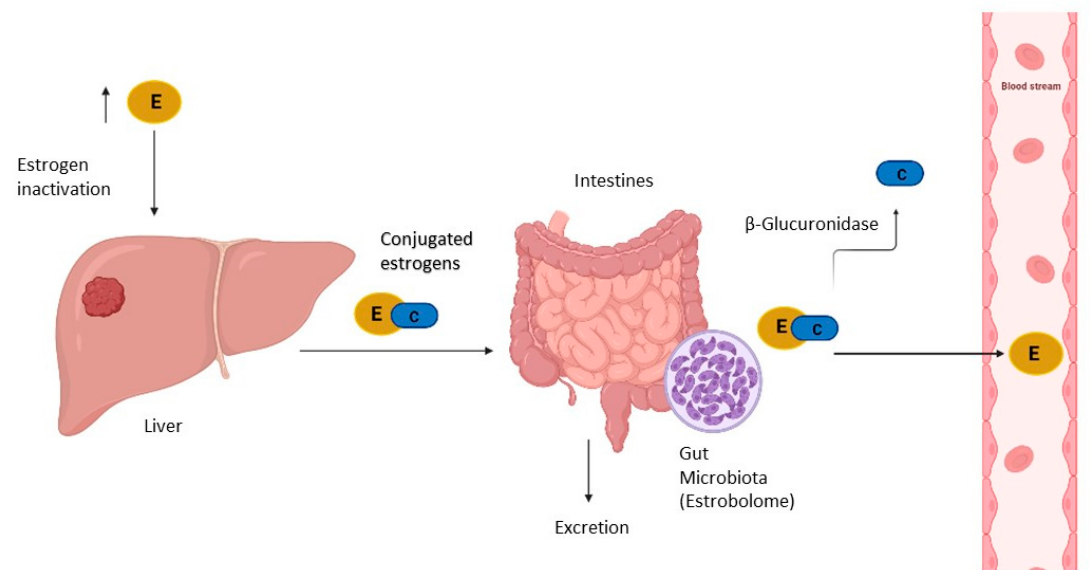
Figure 2. Estrogen metabolism involving gut microbiota (estrobolome). Estrogens are inactivated in liver through conjugation for further excretion. However, some of inactivated estrogens are reabsorbed into the bloodstream across activation in intestines by estrobolome. E: estrogen; C: conjugation with glucuronide acid binding.